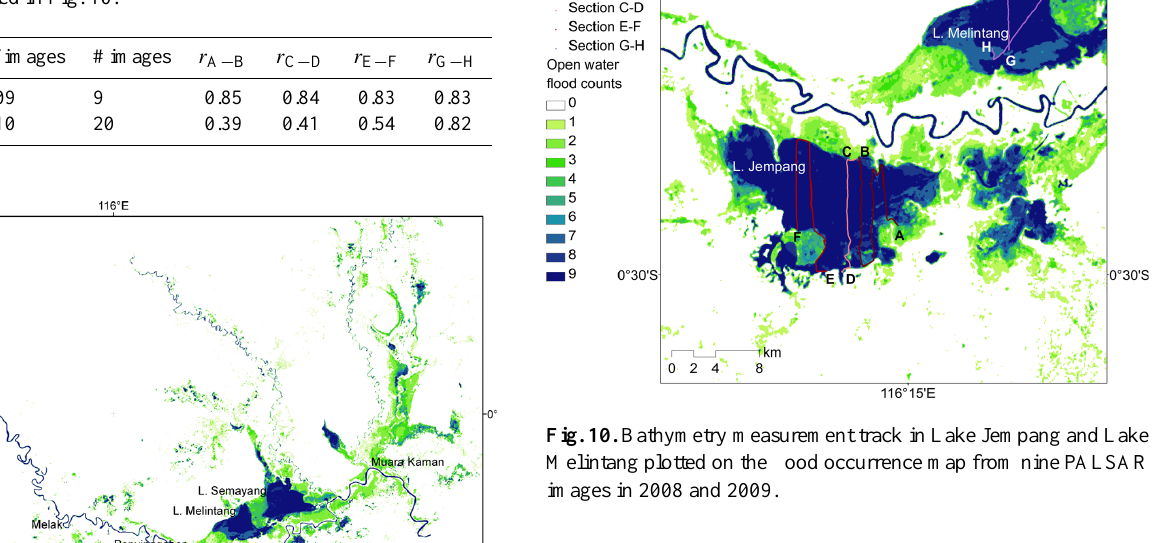
Table 2. Correlation between lake depth and flood occurrence mapped using different periods of PALSAR images for lake sec- tions depicted in Fig. 10.